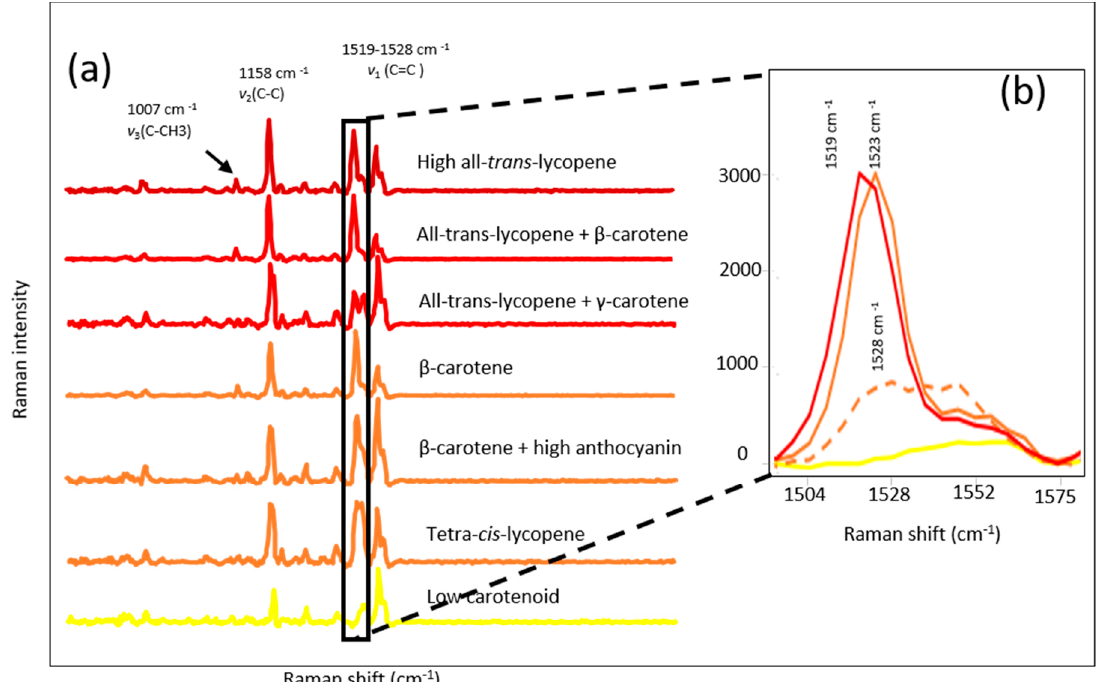
Figure 2. Raman spectra of di ff erent carotenoid profile tomatoes ( a ); colors are representative of fruit color with a few exceptions such as brown / black samples in “ β -carotene + high anthocyanin group”, and ν 1 band shapes and locations for di ff erent class of tomatoes ( b ); Red = all- trans -lycopene samples, solid orange = β -carotene, dashed orange = tetra- cis -lycopene, yellow = low carotenoid samples. High performance chromatography was used for carotenoid profiling of the tomato breeding material including yellow, orange, red, and purple coloration. Four main groups were identified based on HPLC data including (1) all- trans -lycopene, (2) β -carotene, (3) tetra- cis -lycopene, and (4) low carotenoid samples carrying the r gene (Figure